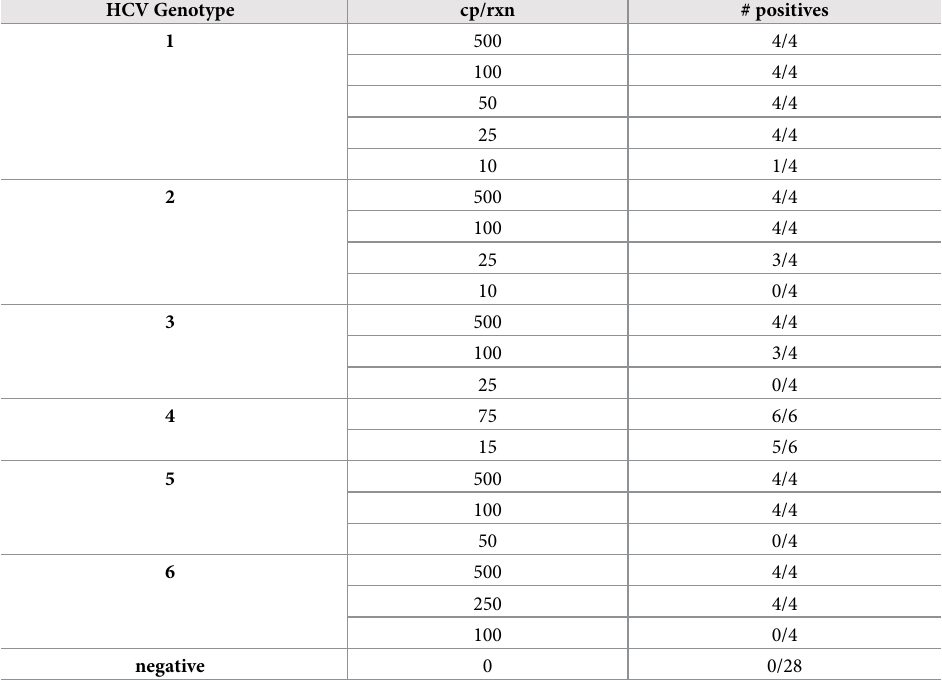
Table 1. Pangenomic HCV RNA detection. Viral RNA from the six HCV genotypes at various input copy numbers were amplified via two-step RT-RPA. Genotyped viral RNA was extracted from HCV-positive human serum and spiked into reverse transcription and RPA reactions for detection. The lowest LODs were observed for genotypes 1 and 4. Genotypes 3 and 6 were the most challenging to detect with inconsistent amplification observed at 100 copies per reaction or less. All no template controls (NTCs) did not amplify in RPA (N = 28).